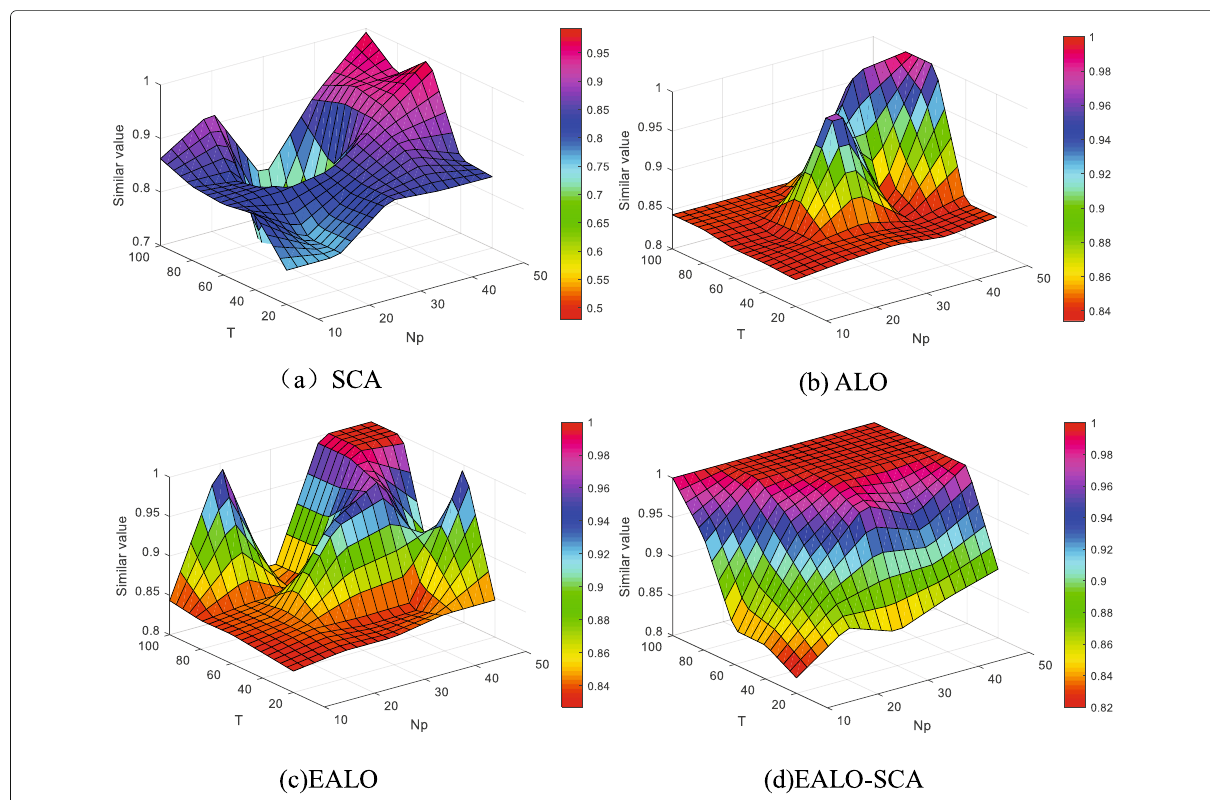
Fig. 9 Similar values against population size Np and number of iteration T . a SCA, b ALO, c EALO, d